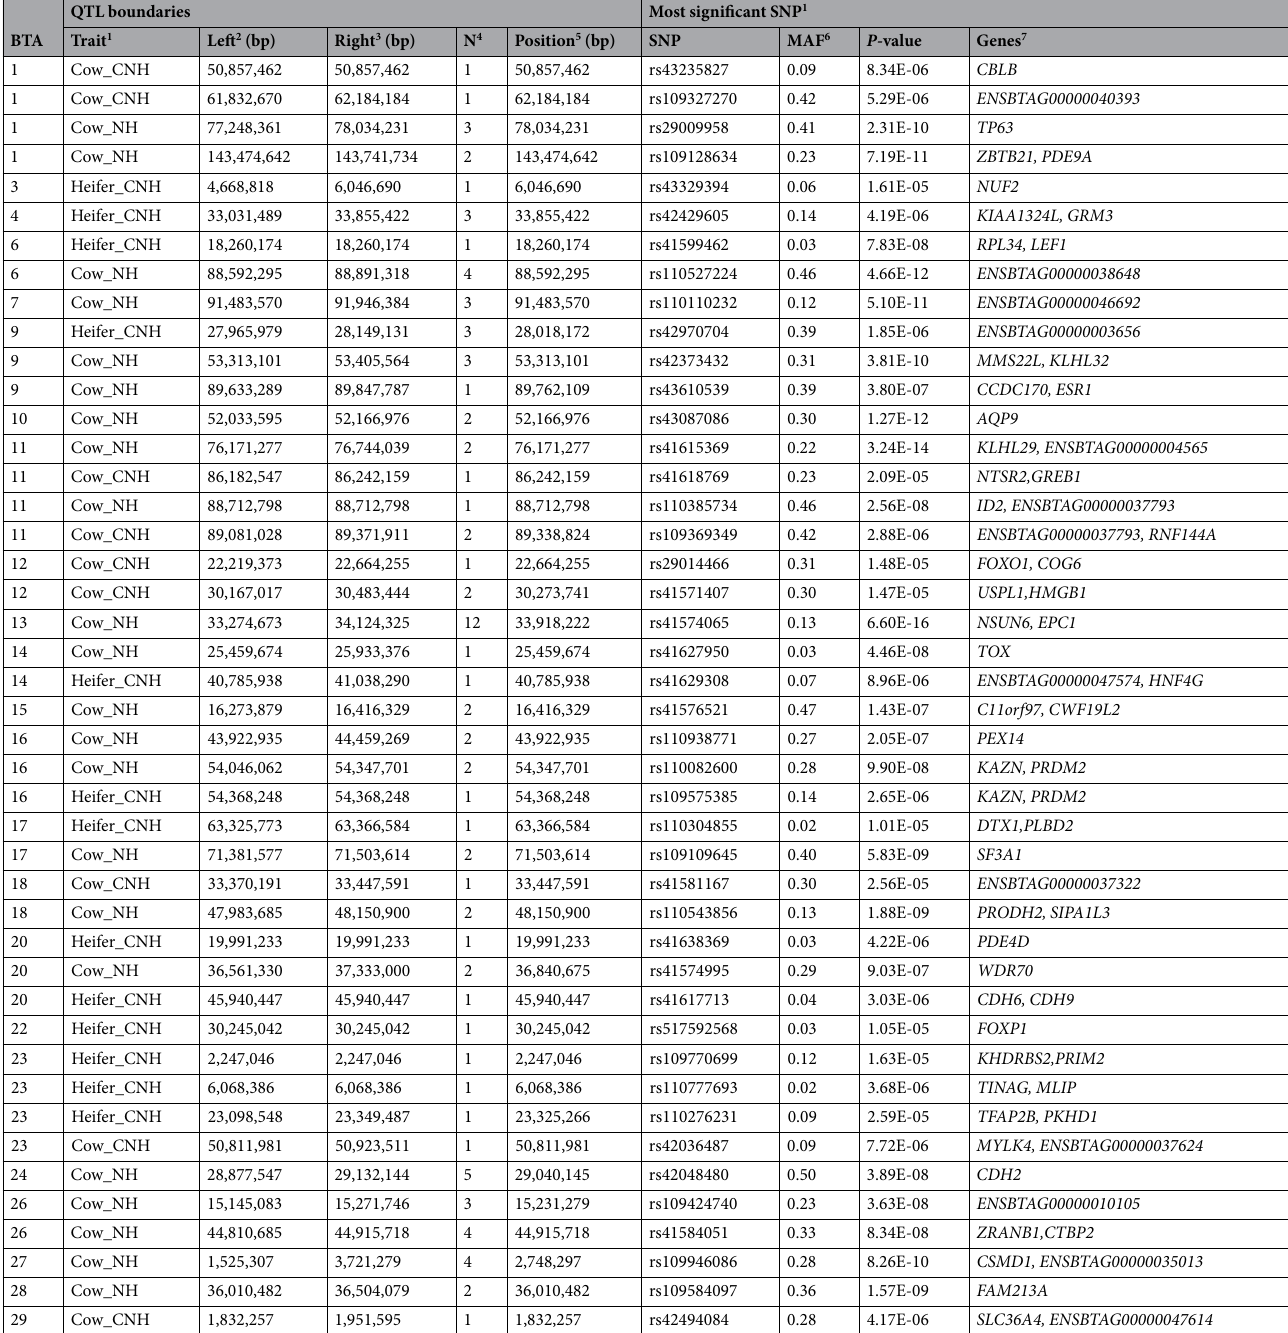
Table 3. The detected QTL and the most significant SNP for female fertility traits in the meta-analysis within population. 1 Heifer_CNH = heifer trait in Chinese Holsteins; Cow_CNH = cow traits in Chinese Holsteins; Cow_NH = cow traits in Nordic Holsteins. 2 The left boundary of the QTL. 3 The right boundary of the QTL. 4 The number of significant SNPs within the QTL. 5 The base pair position in the BTA ( Bos taurus autosome). 7 Genes harbor or closest to the most significant